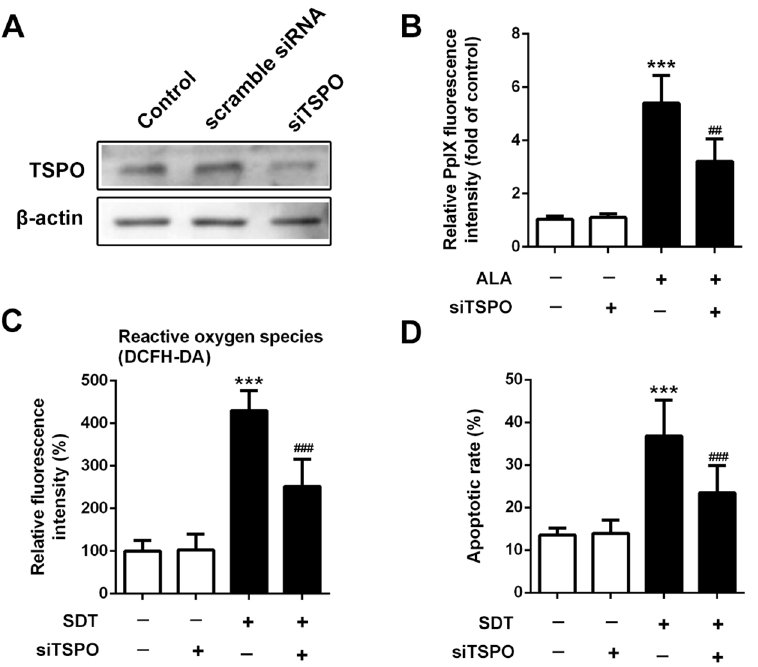
Fig 7. Effect of knockdown of TSPO on PpIX accumulation, SDT-induced ROS generation and cell apoptosis. (A) Knockdown of TSPO in THP-1 macrophages was examined by western blot. (B) Fluorescence intensity of PpIX was measured by fluorescence microplate reader. (C) Fluorescence intensity of ROS was measured using fluorospectrophotometer. (D) Quantifications of early apoptosis rate in the indicated groups. (cid:3)(cid:3)(cid:3) P < 0.001 compared to no treatment group, ## P < 0.01 compared to ALA-SDT treated group, ### P < 0.001 compared to ALA-SDT treated group.